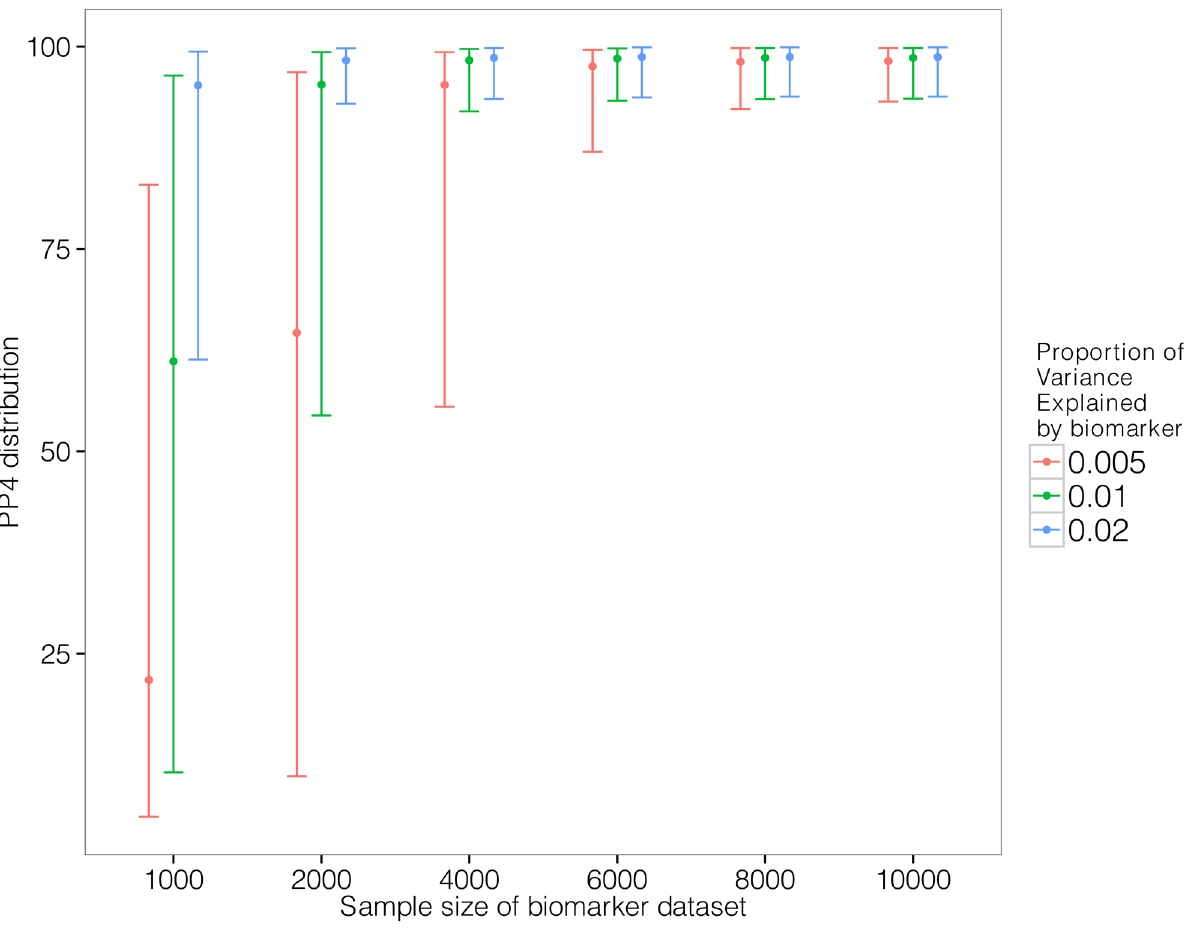
Figure 3. Simulation analysis with a shared causal variant between two studies. The two datasets used are one eQTL (sample size 966 samples, 10% of the variance explained by the variant) and one biomarker (such as LDL). The variance explained by the biomarker is colour coded and the x-axis shows the sample size of the biomarker study. The y axis shows the median, 10% and 90% quantile of the distribution of PP4 values (which supports a shared common variant).